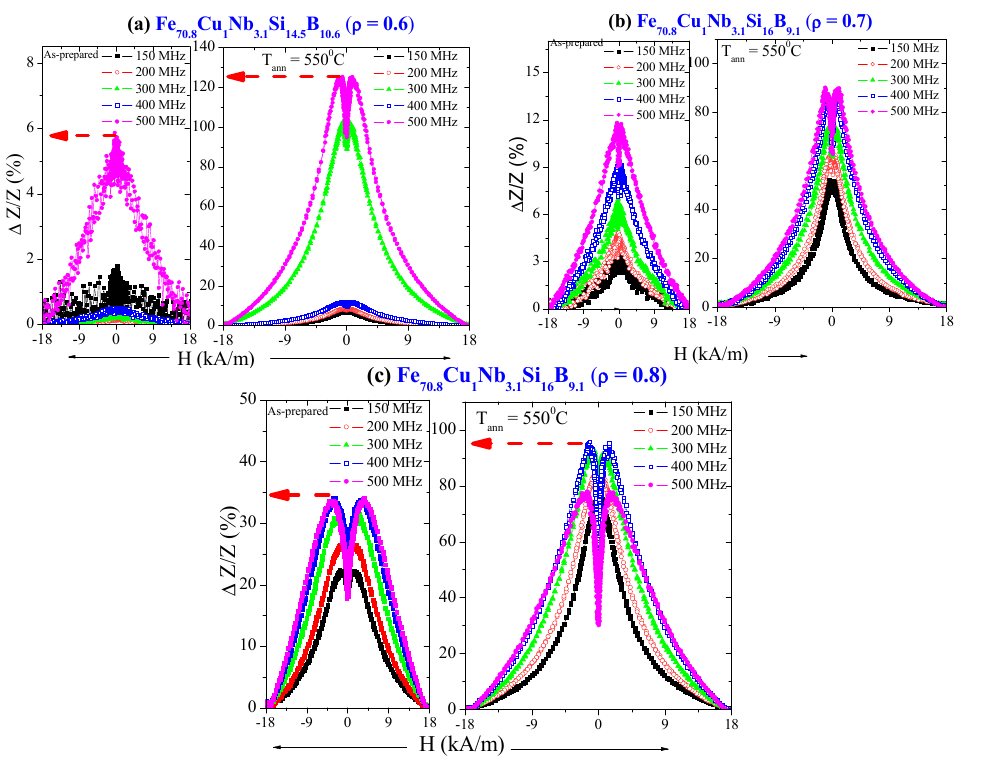
Figure 9. Δ Z/Z (H) of as-prepared and annealed Fe 70.8 Cu 1 Nb 3.1 Si 14.5 B 10.6 at T ann = 550 °C of for ρ -ratio = 0.6 ( a ); Δ Z/Z (H) of Fe 70.8 Cu 1 Nb 3.1 Si 16 B 9.1 for ρ -ratio= 0.7 ( b ); and ρ -ratio = 0.8 ( c ). Driving frequencies are provided in each figure. Reproduced from reference [47], Figure 6.